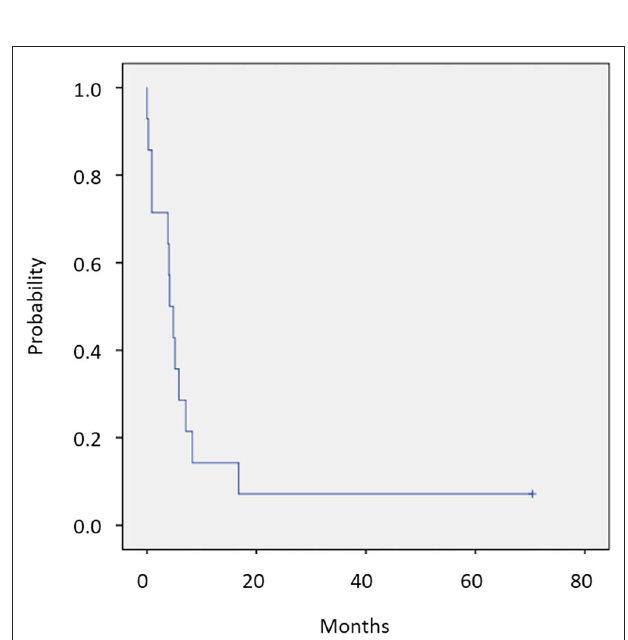
FIGURE 2 | Overall survival ( N = 14). OS was not reached with observed death events of 2.